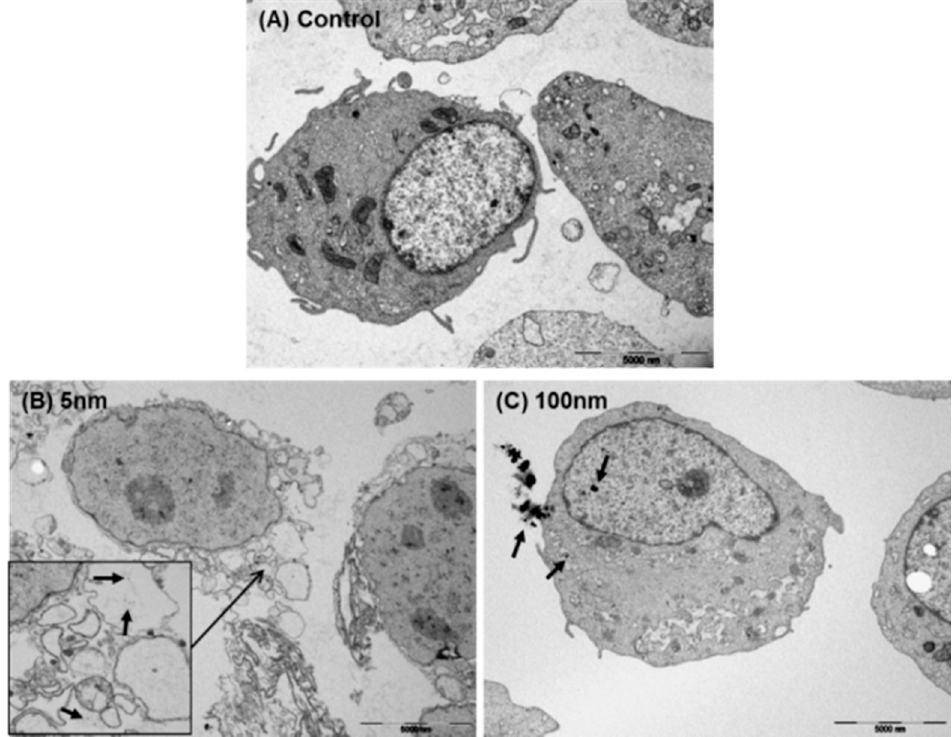
Figure 8. Transmission electron microscopy images of intracellular silver NP localization. ( A ) Untreated cells showed no abnormalities. ( B ) Cells treated with 5 nm silver NPs showed NP internalization, mitochondrial swelling, decrease or disappearance of cytoplasm, and vacuolization. ( C ) Cells treated with 100 nm silver NPs showed no clear changes in cell morphology. Images shown are representative of three independent trials.